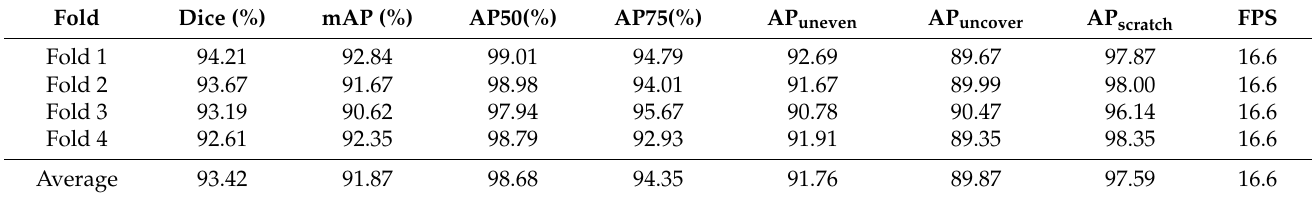
Table 10. Four-fold cross validation result, where FPS denotes for frame per second by using the YOLOv3+Unet model. In total, the number of parameters used is 69,537,100. The YOLOv3 detects the defect area, and then the Unet segment the